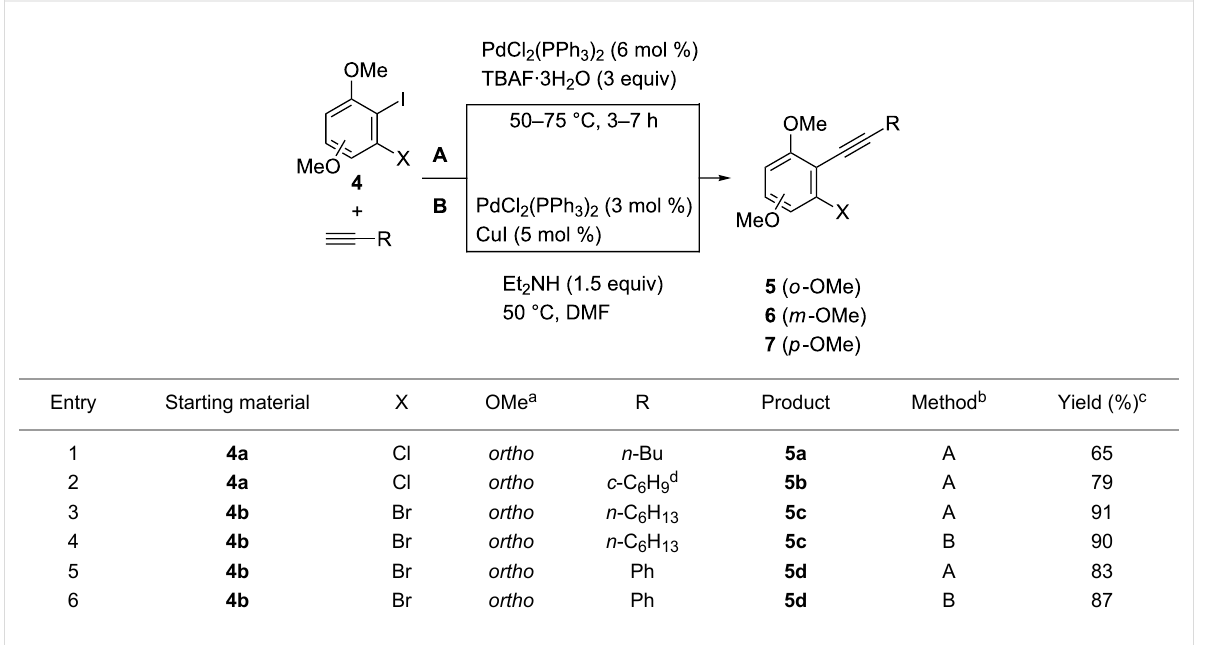
Table 2: Synthesis of dimethoxy-substituted o -alkynylhaloarenes 5 – 7